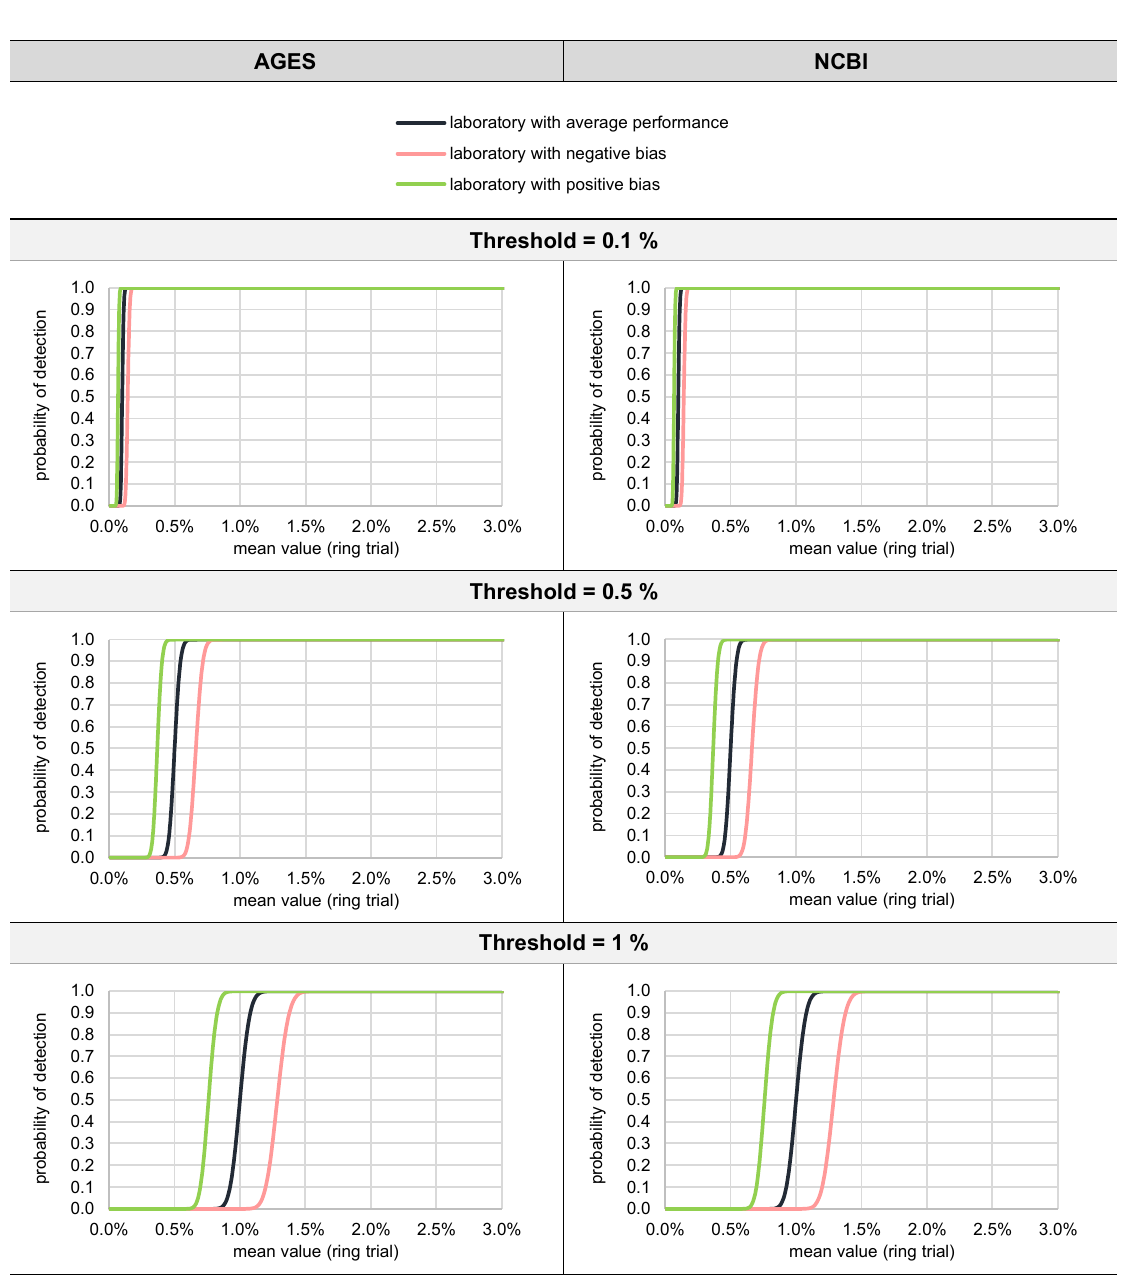
Figure 7. Probability of detection for a laboratory with average performance, a laboratory with positive bias, and a laboratory with negative bias, depending on the threshold and the database. Figure 7 indicates that a threshold value of 1% seems to be a good compromise, pro- vided that the variance function determined in the ring trial is equal to the actual variance function. A threshold value of 1% guarantees that a laboratory with a positive bias (over- estimating the actual proportion) does not complain if the proportion of a certain animal species is 0.5%, whereas even a laboratory with a negative bias (underestimating the ac- tual proportion) will be able to identify proportions >1.5% reliably. 3.3. Negative Control Sample 8 was a DNA extract from maize, serving as a negative control. Since the marker system designed for mammals and poultry species does not detect maize, all reads that were obtained for sample 8 had to be regarded as false positive.